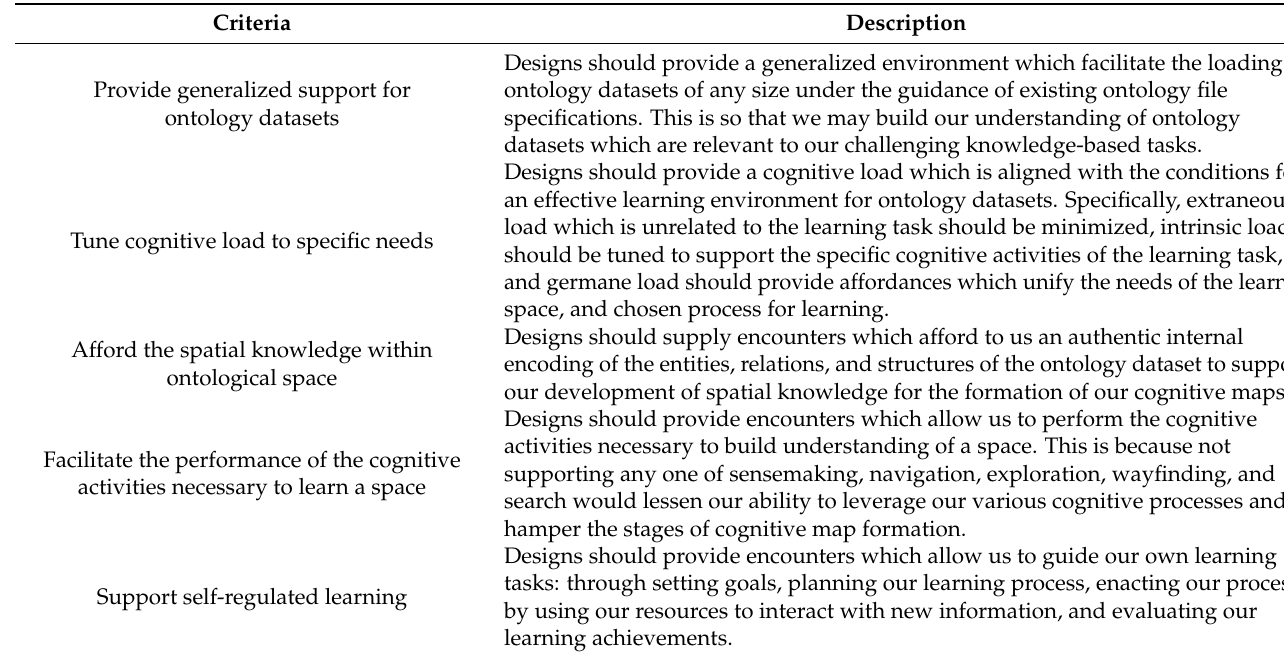
Table 2. The high-level criteria for designing interactive visualization tools of ontology datasets which promote the stages of cognitive map formation for learning